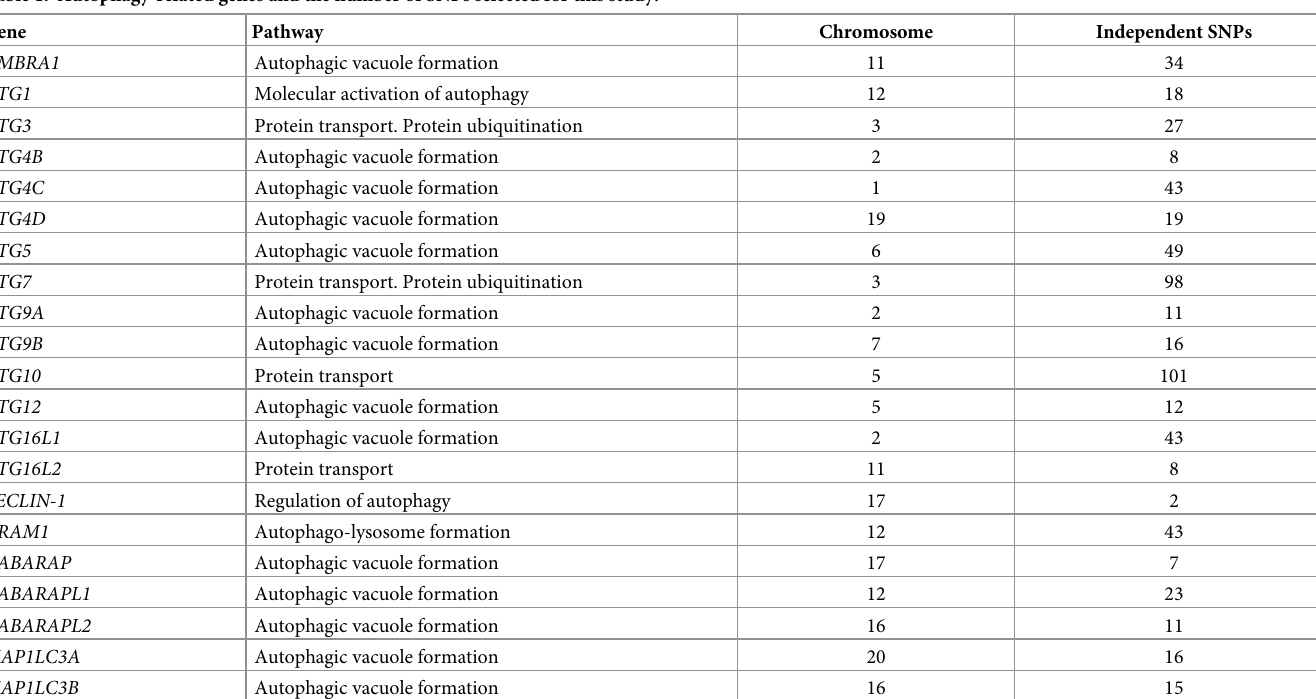
Table 1. Autophagy-related genes and the number of SNPs selected for this study.